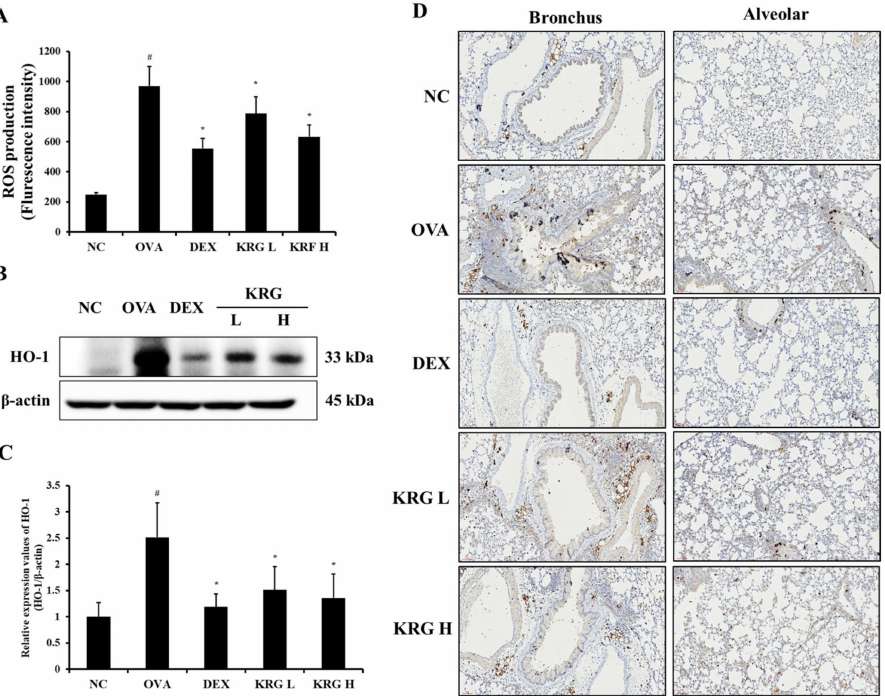
Figure 5. Korean red ginseng (KRG) reduces the levels of reactive oxygen species (ROS) production ( A ) in the bronchoalveolar lavage fluid (BALF) and expression of heme oxygenase-1 (HO-1) ( B ) in the lung tissues, of which ( C ) densitometric values were determined utilizing Chemi-Doc. ( D ) HO-1 ex- pression in the bronchus and alveolar regions of lung tissues was revealed by immunohistochemistry (IHC). Normal control (NC) group; mice administered with the vehicle, ovalbumin (OVA), group; mice treated with OVA and administered with the vehicle, dexamethasone (DEX), group; mice treated with OVA and administered with dexamethasone (3 mg/kg); KRG low (KRG L) and high (KRG H) groups; mice treated with OVA and administered with KRG (100 and 300 mg/kg, respectively). Values: means ± standard deviation ( n = 6). Significance: # p < 0.05 vs. NC; * p < 0.05 vs. OVA.